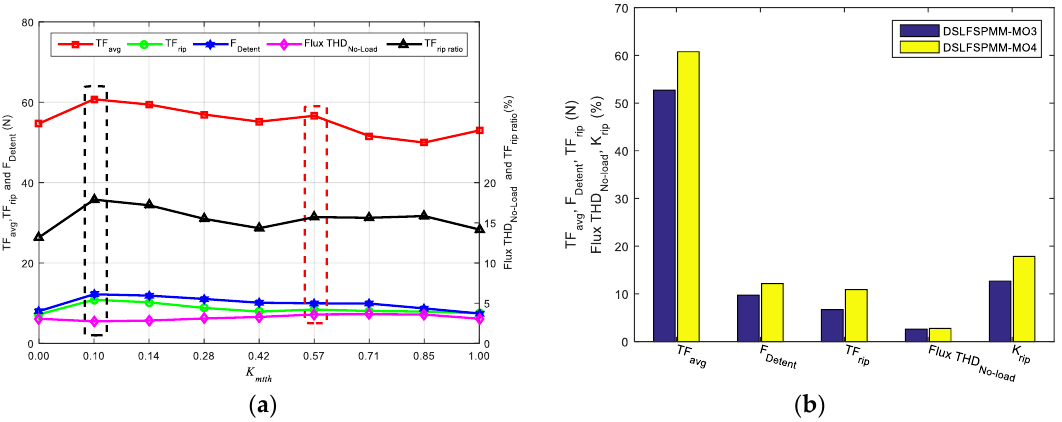
Figure 15. Mover tooth tip height optimization: ( a ) Performance comparison of DSLFSPMM-O3 having different 𝐾 𝑚𝑡𝑡ℎ values; ( b ) Performance comparison of DSLFSPMM-MO3 and DSLFSPMM- MO4.